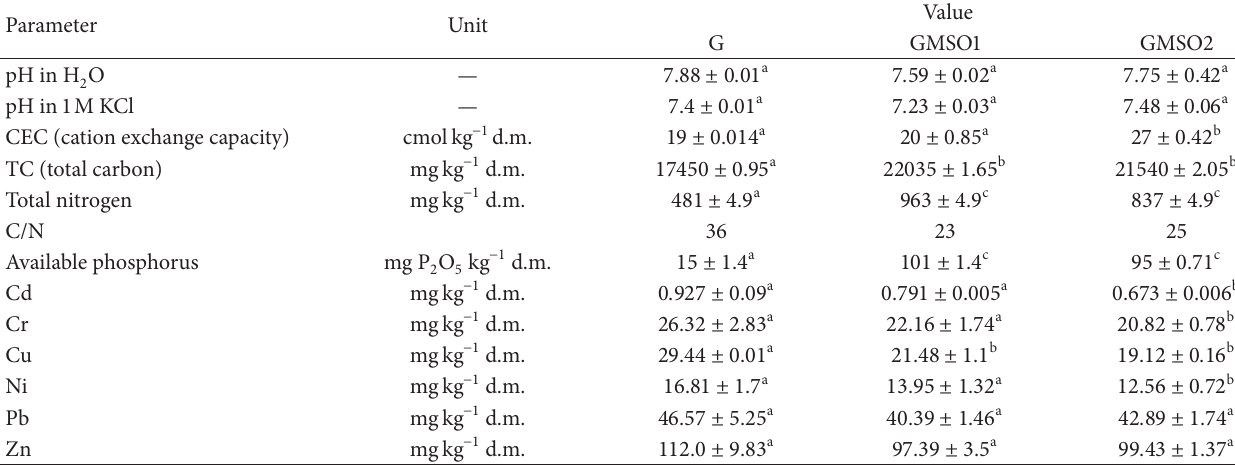
Table 1: Physiochemical characteristics of soil (G) and soil mixed with biopreparations (MSO1 and MSO2) used in the experiment. Parameter Unit